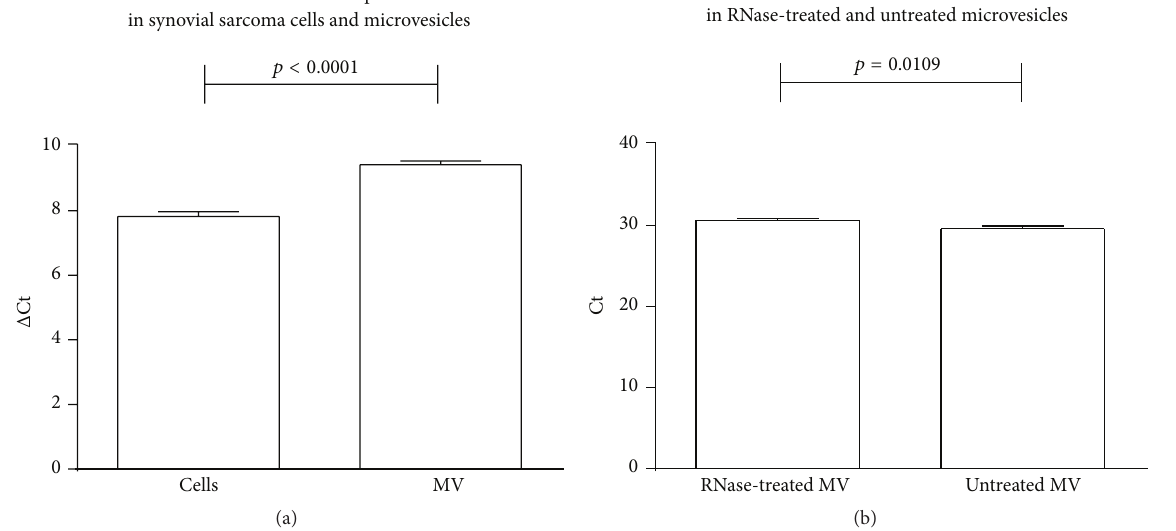
Figure 5: (a) Relative expression of the SYT-SSX2 fusion gene transcript in synovial sarcoma cells and microvesicles, normalized to GAPDH. (b) Expression of the SYT-SSX2 fusion gene transcript in microvesicles treated with RNase A and untreated microvesicles. MV: microvesicles.